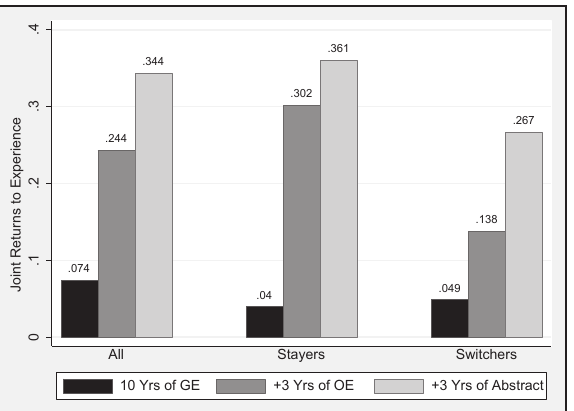
Figure 3 Joint returns to experience – two-digit level. Returns to 10 years of GE and 0 years of OE and TE are not statistically significant at any of the conventional levels for the samples of “All immigrants”, “Stayers”, and “Switchers”. Returns to 10 years of GE, 3 years of OE, and no TE are significant at the 1% and 10% levels for the “All immigrants” and “Stayer” samples, respectively. Returns to 10 years of GE, 3 years of OE, and no TE are not significant at any of the conventional levels for the Switcher sample. Return to 10 years of GE, 3 years of OE, and 3 years of Abstract TE is significant at the 1%, 5%, and 1% levels for the “All immigrants”, “Stayers”, and “Switcher” samples,